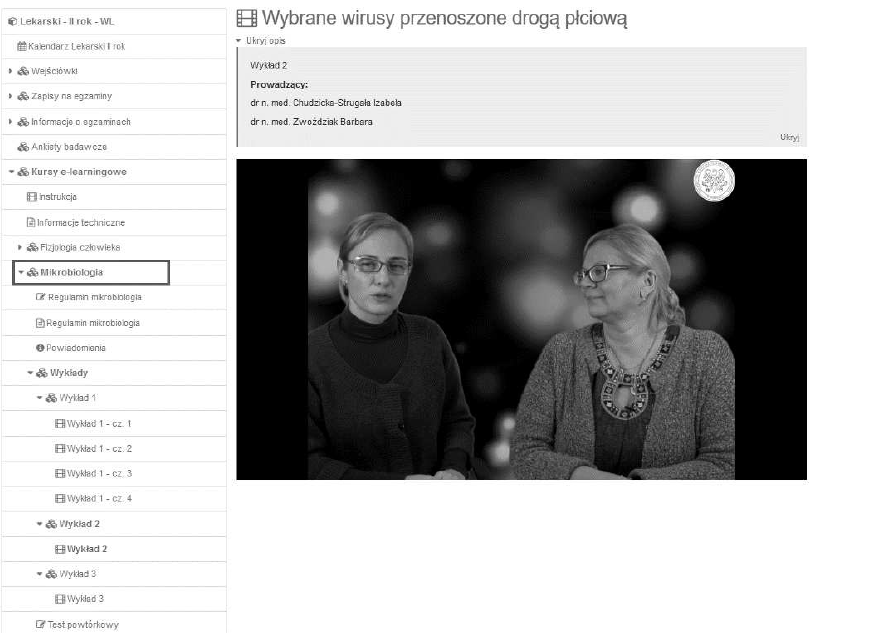
Figure 2. E-learning course in Medical Microbiology for year 2 students of